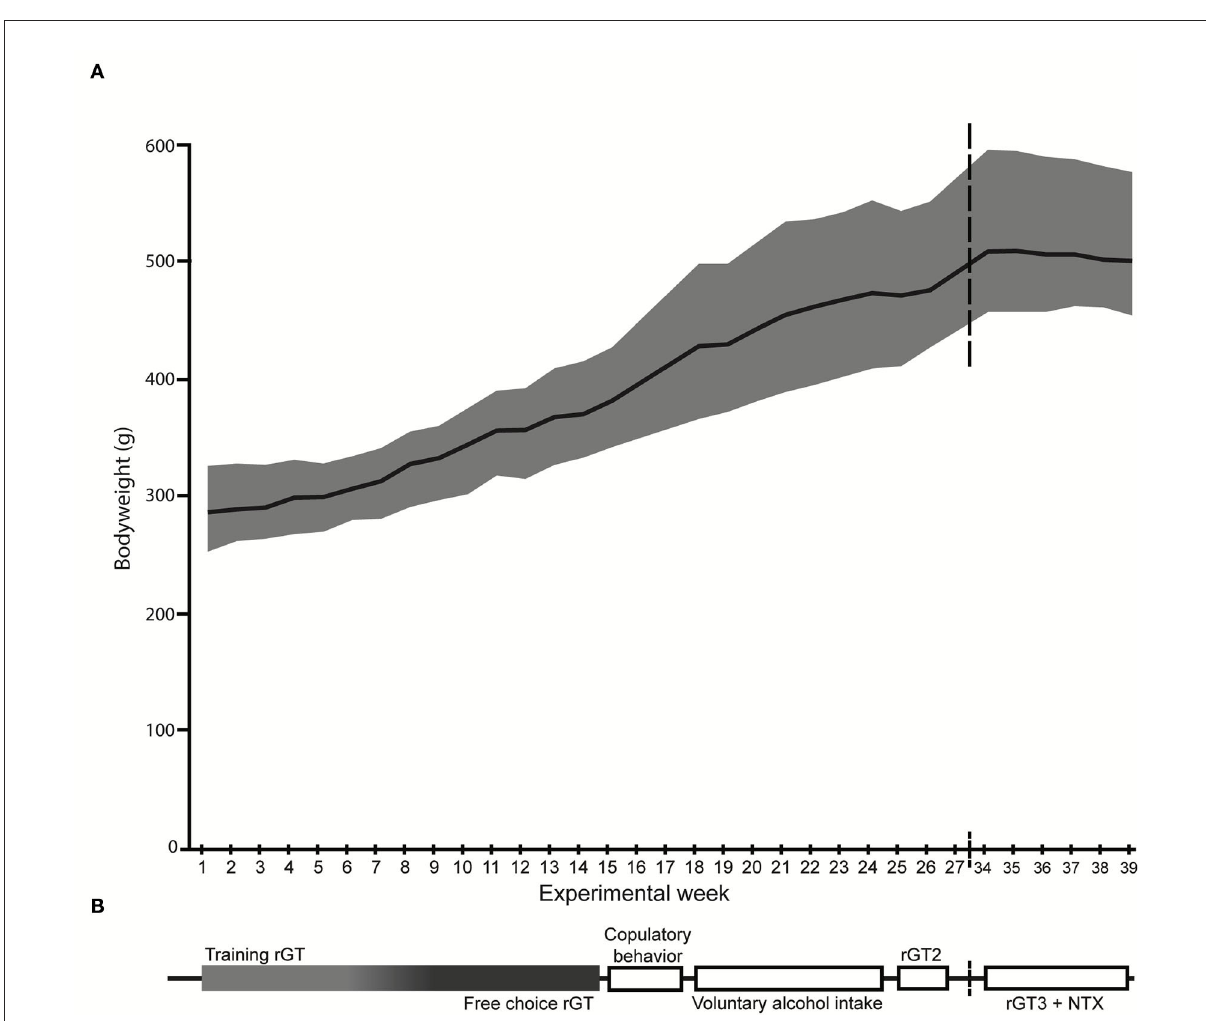
FIGURE1 Overview of the experimental procedures. (A) The mean body weight (g) is displayed by the black line and the gray shadow shows the body weight range. (B) The experimental outline with the order of tests shown, corresponding to the weeks on the x -axis in (A) . NTX, naltrexone; rGT, rat gambling